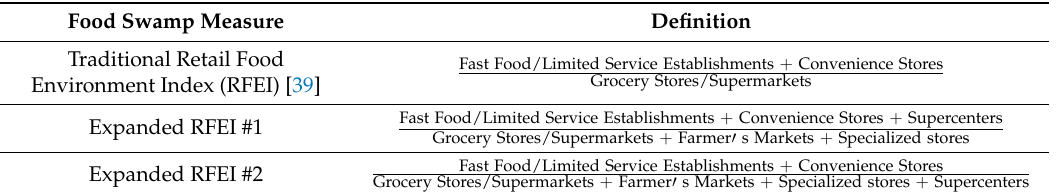
Table 1. Food Swamp Measures.